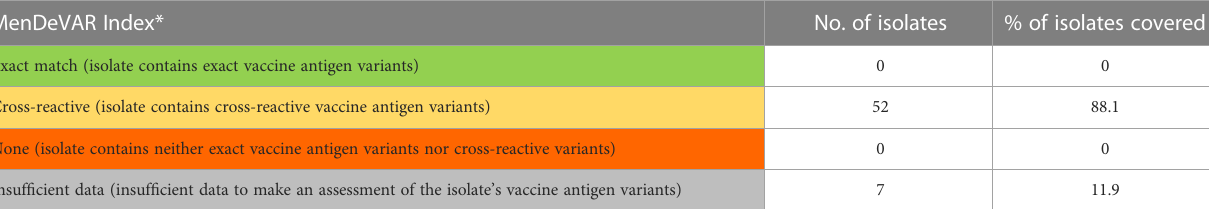
*Data interpretation using the traf fi c light colors was applied as described in the Materials and Methods section and Table 2 by Rodrigues et al. (2020).